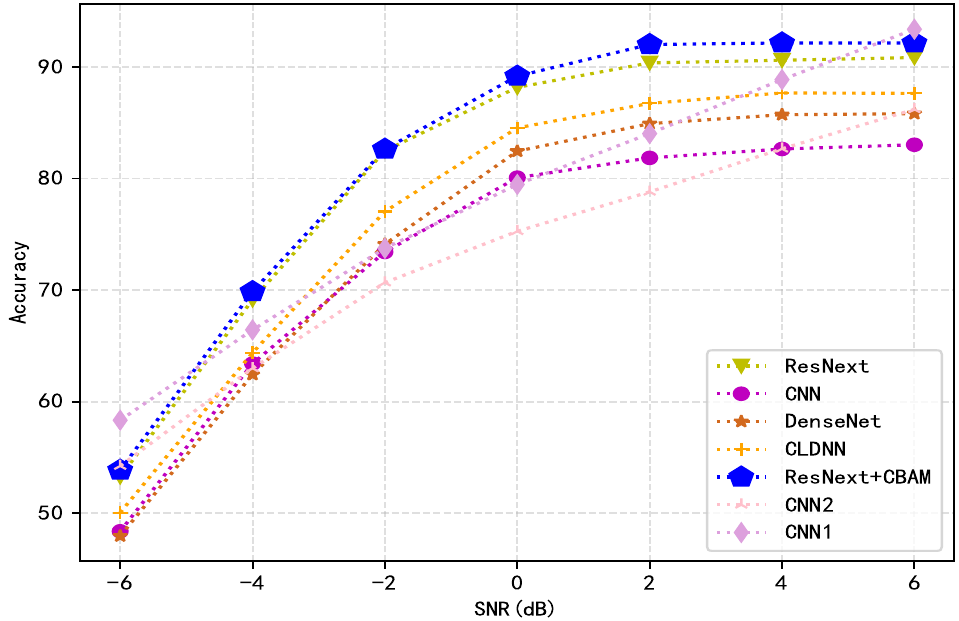
Figure 9. Average recognition accuracy under different